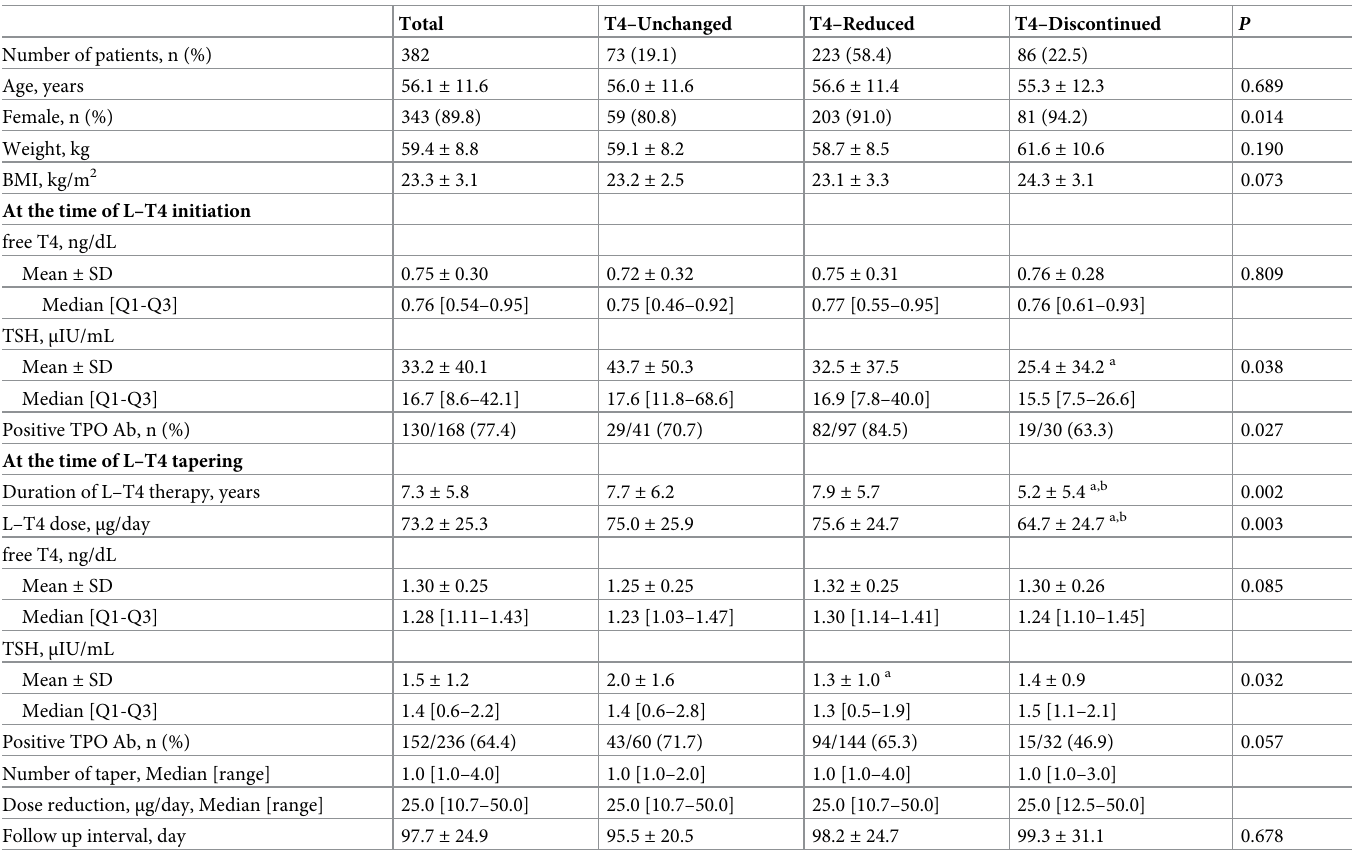
Table 1. Comparisons of clinico-biochemical characteristics among the different outcome groups after L–T4 tapering.